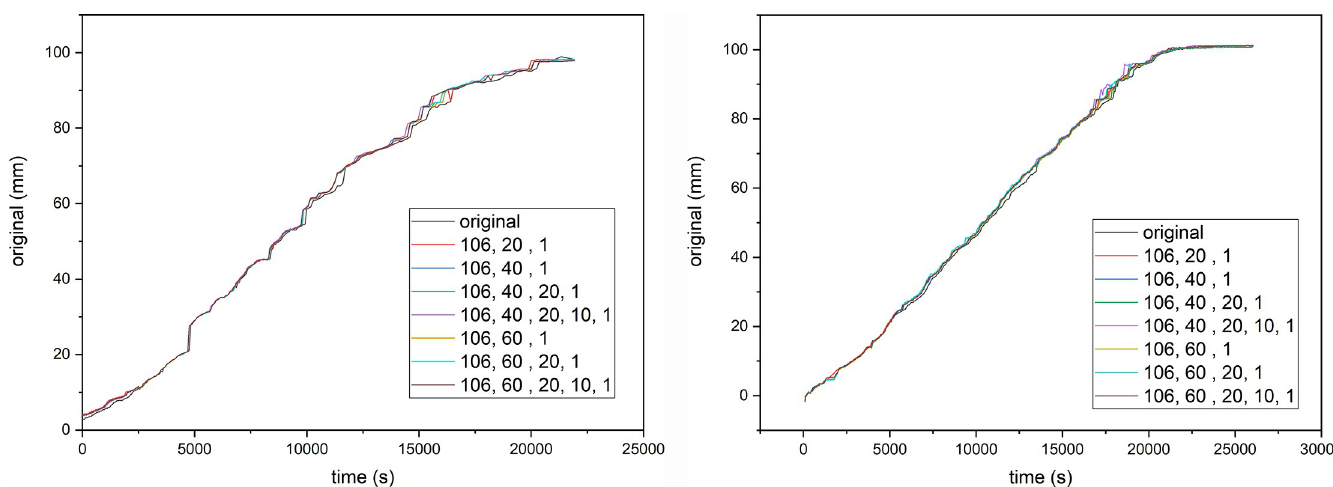
Fig 11. Influence of design on the final result a) Sample 1- bamboo and b) Sample 2- cotton knitted fabrics.